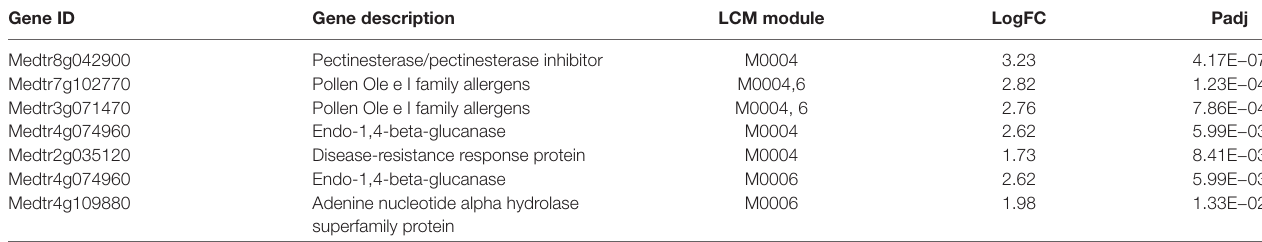
TABlE 1 | Genes assigned to modules consisting of entirely of up regulated genes at 24 h post-inoculation (24U). If a gene appeared in multiple modules, only the last digit of the module number is listed for the additional modules. LogFC is the log 2 fold change in expression between the two conditions for each gene and Padj is the Benjamin-Hochberg adjusted p value as reported by DESeq2.